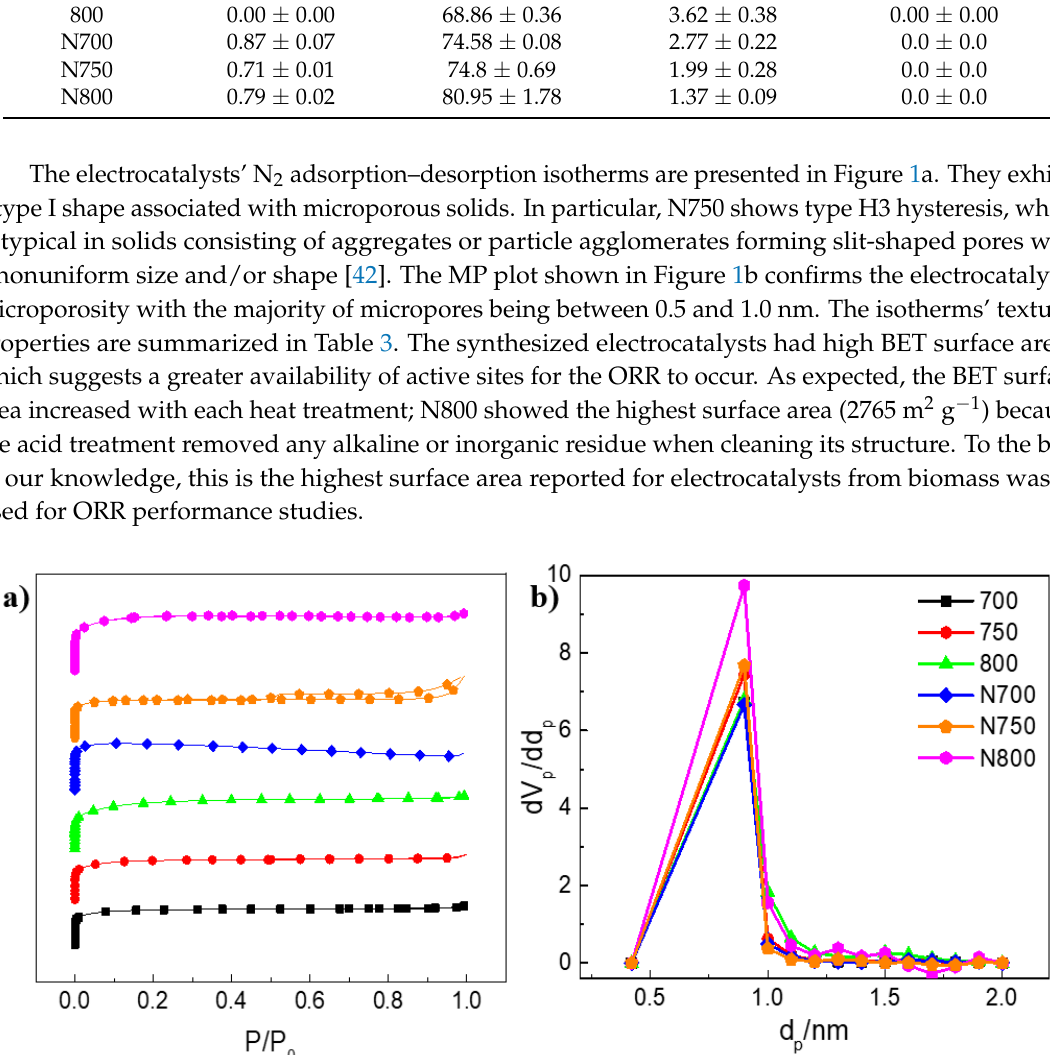
Table 2. Analysis of elemental CHNS composition (wt %) of the electrocatalyst bulk.